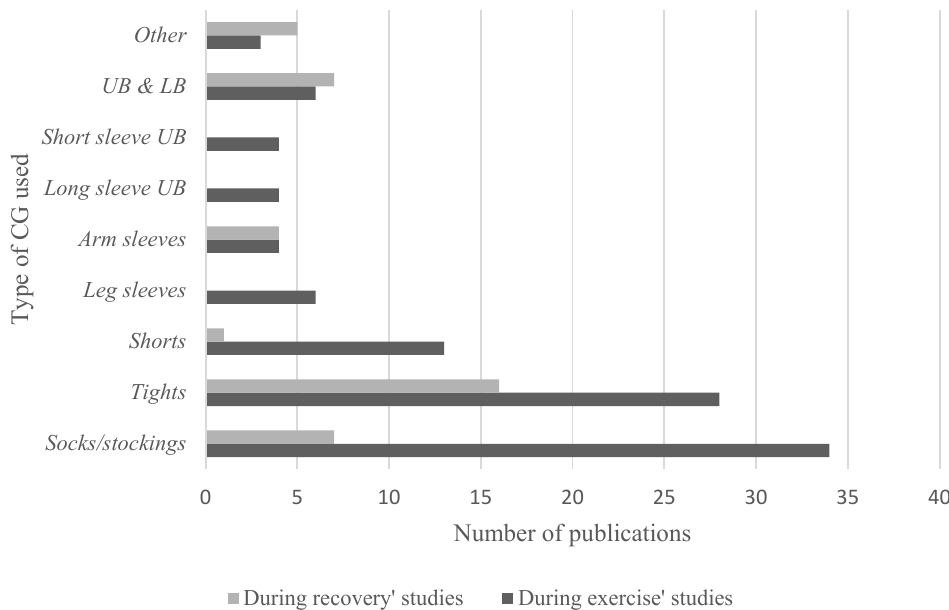
Figure 3. Types of compression garments used in the publications included in review. ‘UB’ = upper body, ‘LB’ = lower body, ‘CG’ = compression garment.